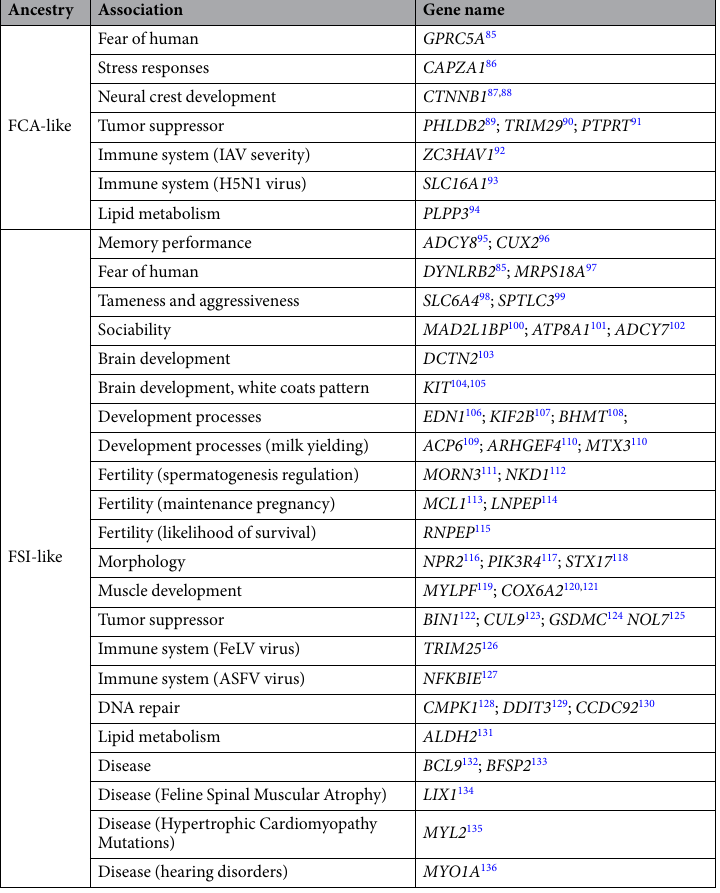
Table 1. Subset of significantly enriched GO domestic-like (a) and wildcat-like (b) outlier genes detected in the domestic x wildcat admixed cats, identified with Bayesian analysis in Admixture and PCAdmix, which have been previously described in